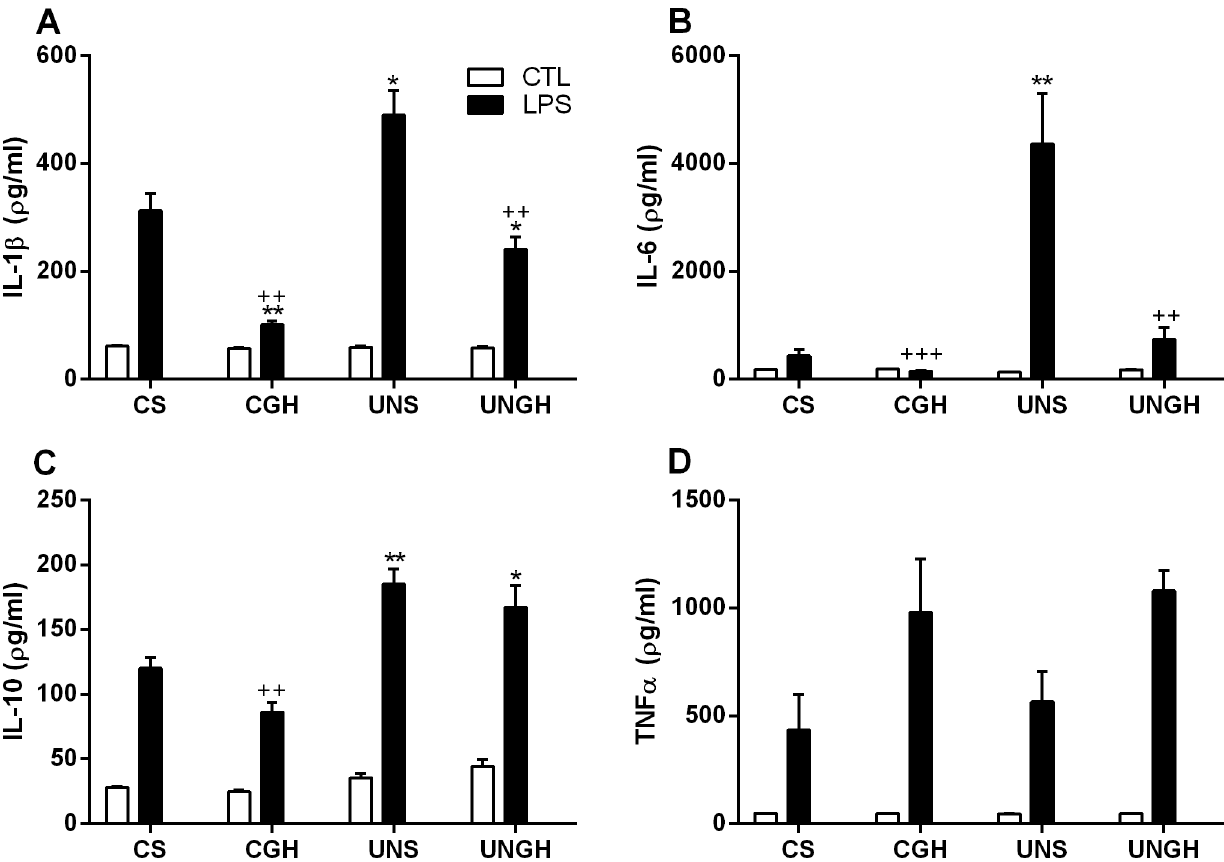
Figure 2. Bone marrow was isolated from CS, CGH, UNS and UNGH male adult rats. Cells were cultured for 7 d in the presence of M-CSF (50 ng/ml) to differentiate to BMM. Once differentiated BMM were stimulated for 6 h with LPS (100 ng/ml). Cytokine analysis for (A) IL-1 b , (B) IL-6, (C) IL-10 and (D) TNF a was carried out using Quantikine ELISA (*p , 0.05, **p , 0.01, ***p , 0.001 w.r.t CS; + p , 0.05, ++ p , 0.01, +++ p , 0.001 w.r.t UNS, n=4). Values were expressed as mean 6 SEM.